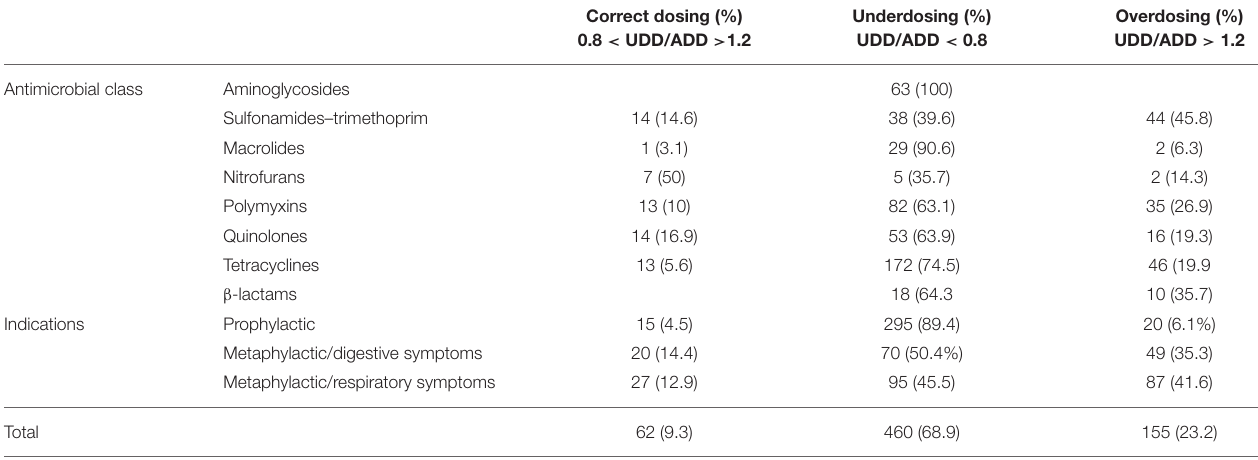
TABLE 4 | Correctness of dosage (UDD/ADD ratio) according to the different antimicrobial classes administered and different indications of use in layer farms in the West Region in Cameroon between January and December 2012.